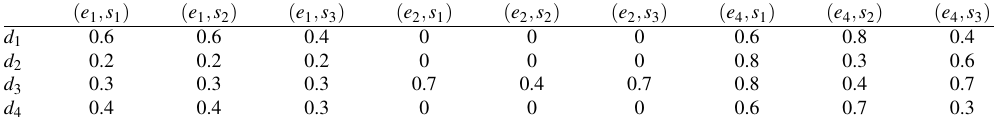
Table 17: Tabular representation of the fuzzy soft set ( F , A ) ∧ ( G , B